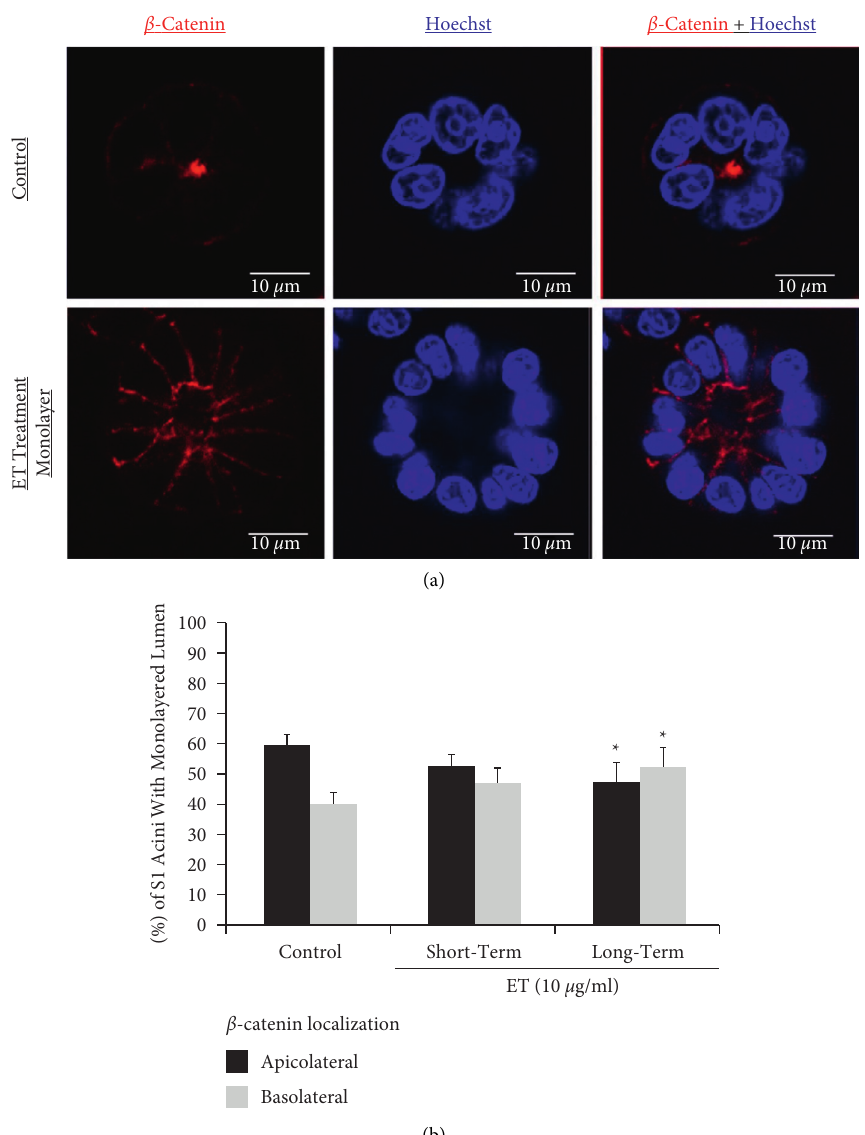
Figure 6: Long-term endotoxin treatment alters β -catenin localization in 3D cultures of human breast epithelial S1 cells. (a) Representative S1 acini immunostained for β -catenin (red) and counterstained with Hoechst (blue). The upper lane shows a control untreated S1 acinus with undisrupted monolayered lumen and apicolateral β -catenin localization. The lower lane shows an S1 acinus following ET treatment at 10 μ g/ml revealing relocalization of β -catenin from the apicolateral to the lateral and basolateral domain while maintaining undisrupted monolayered lumen. (b) Quantification data of β -catenin localization shows significant redistribution of β -catenin from the apicolateral to the basolateral domain in S1 acini with monolayered lumen after long-term ET treatment at 10 μ g/ml. Localization of β -catenin was evaluated under confocal microscopy. One hundred acini with monolayered lumen from every replicate were visualized, and each acinus was scored for polarity based on the β -catenin (red) localization as apicolateral versus basolateral. Each bar represents triplicate analyses of mean ± SD. ∗ P < 0 . 05 compared to the untreated